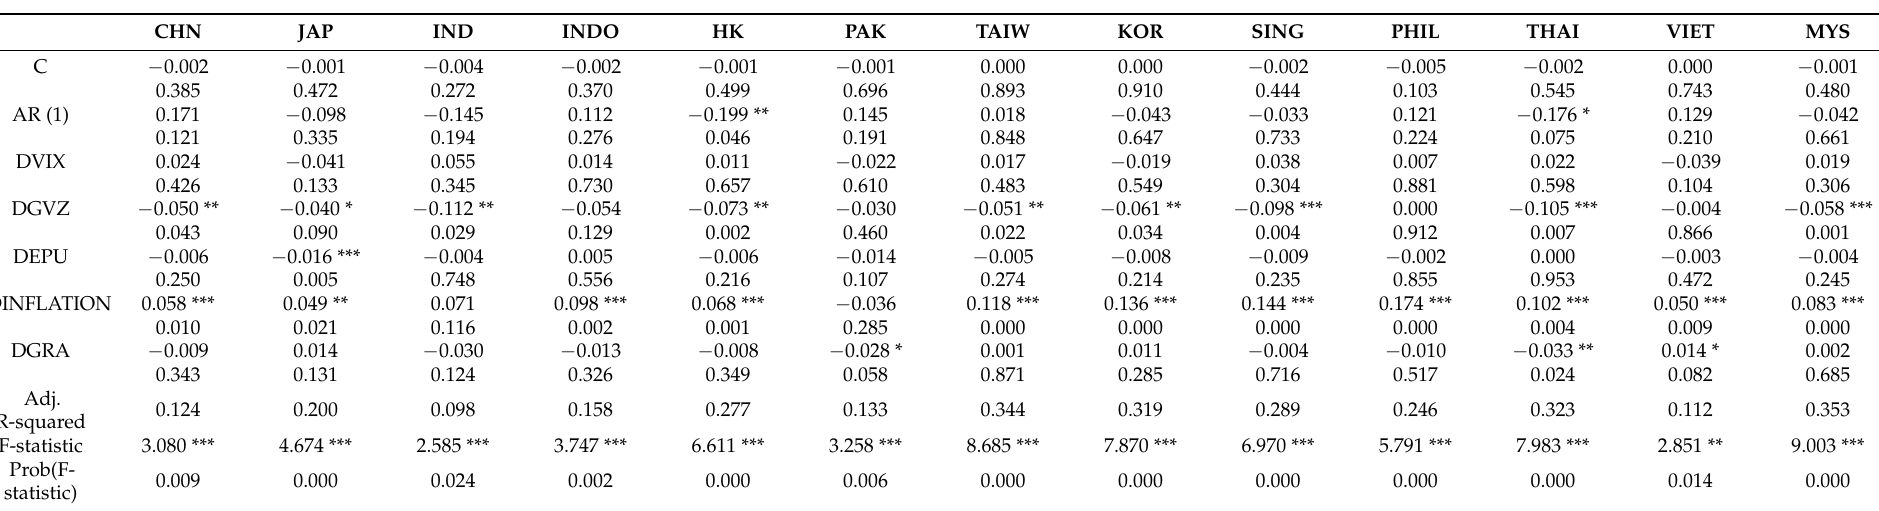
Table 7. Determinants of the hedge portfolio returns during the COVID-19